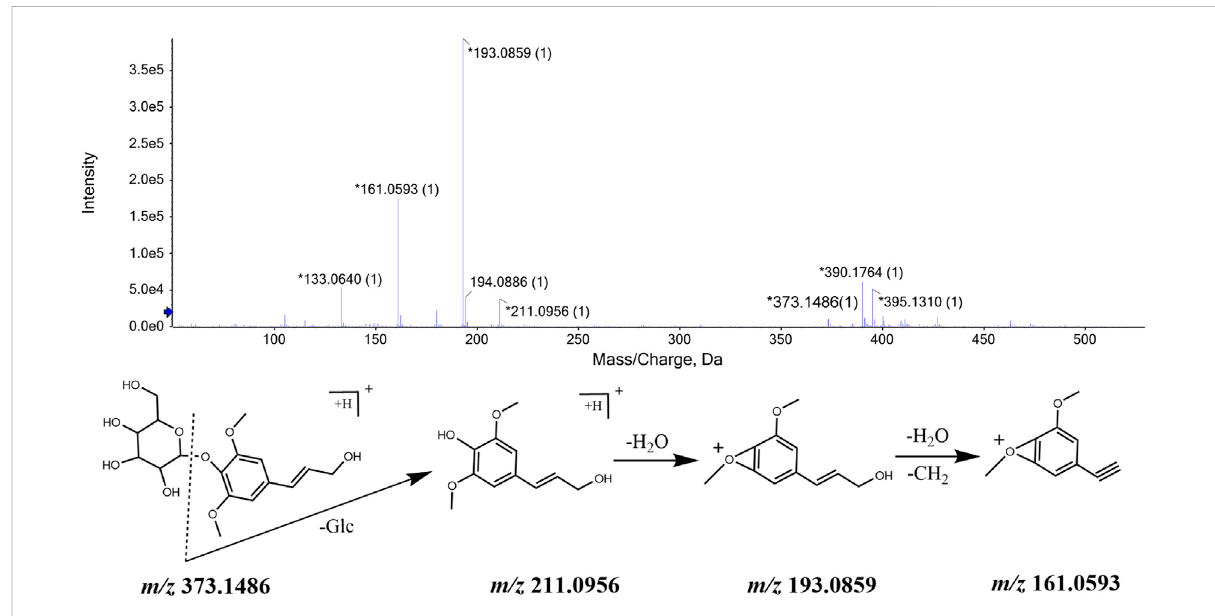
FIGURE 3 MS/MS spectrum of eleutheroside B in CWT and speculated fragmentation